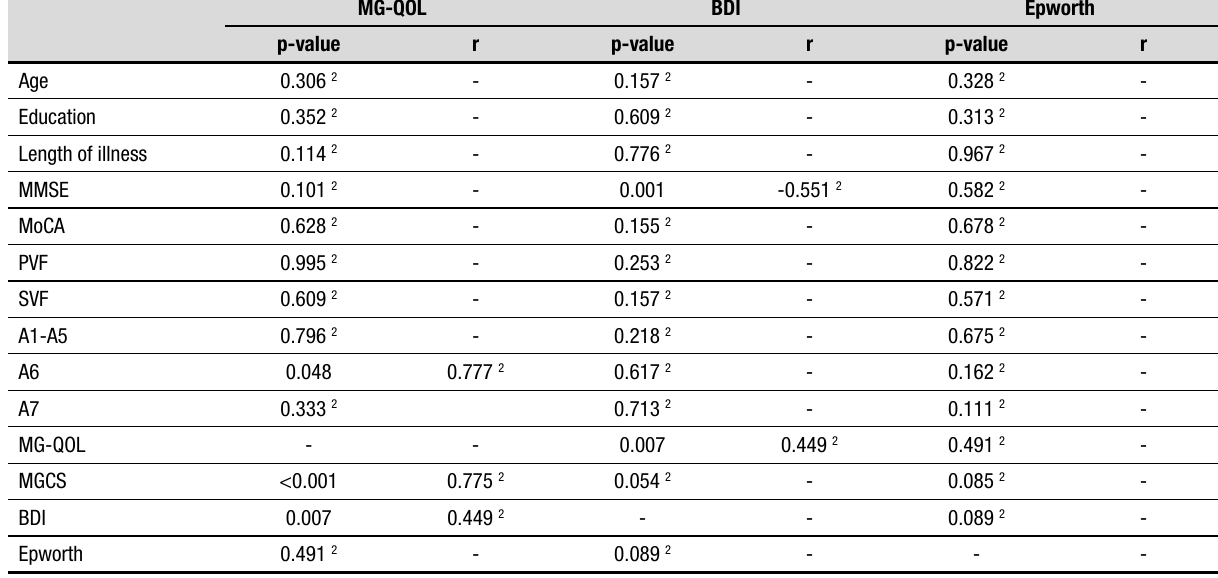
Table 3. Correlations between questionnaires and cognitive